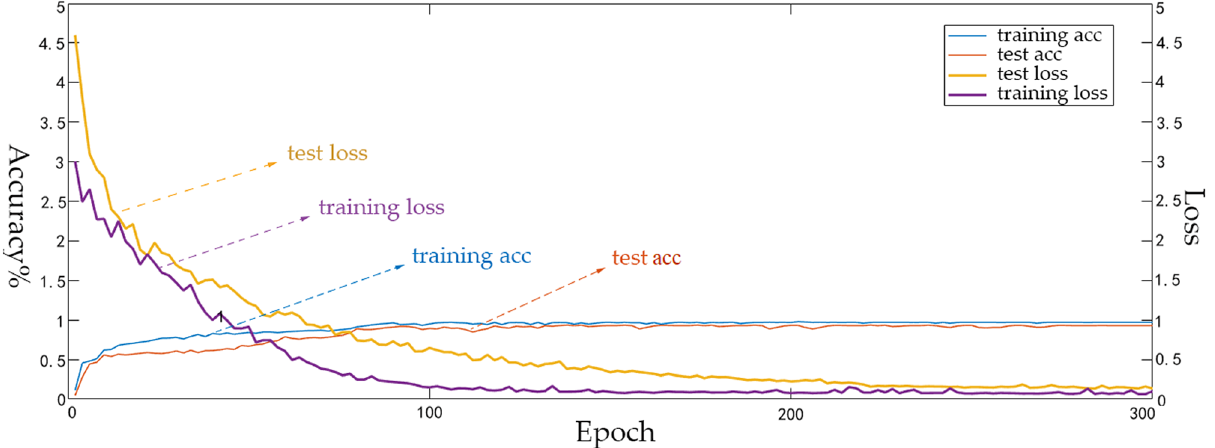
Figure 10. The accuracy and loss of the experiment.